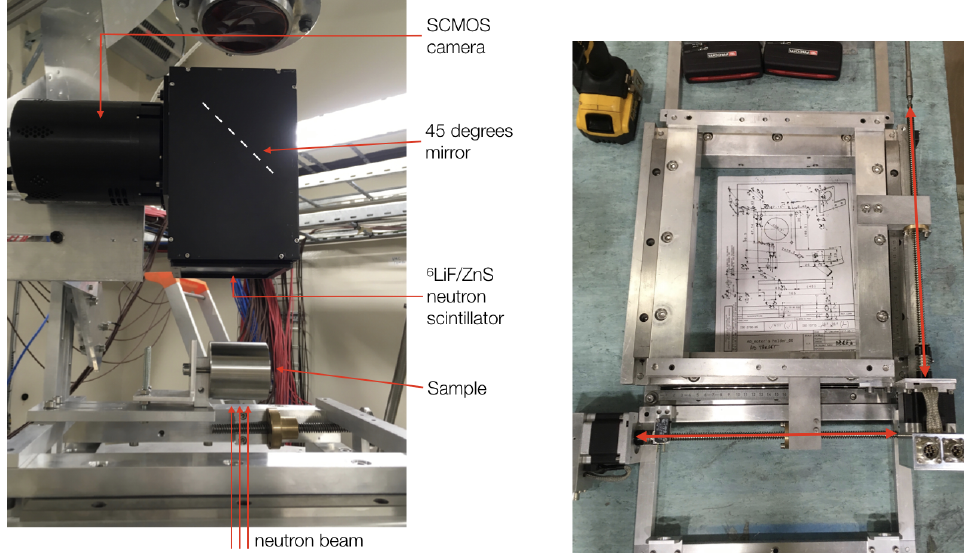
Figure 5. ( Left ) Image of the imaging measuring setup in the Experimental Area 2, with the different parts of the setup. ( Right ) The sample can be moved in the plane perpendicular to the beam direction to adjust its position with a dedicated movable